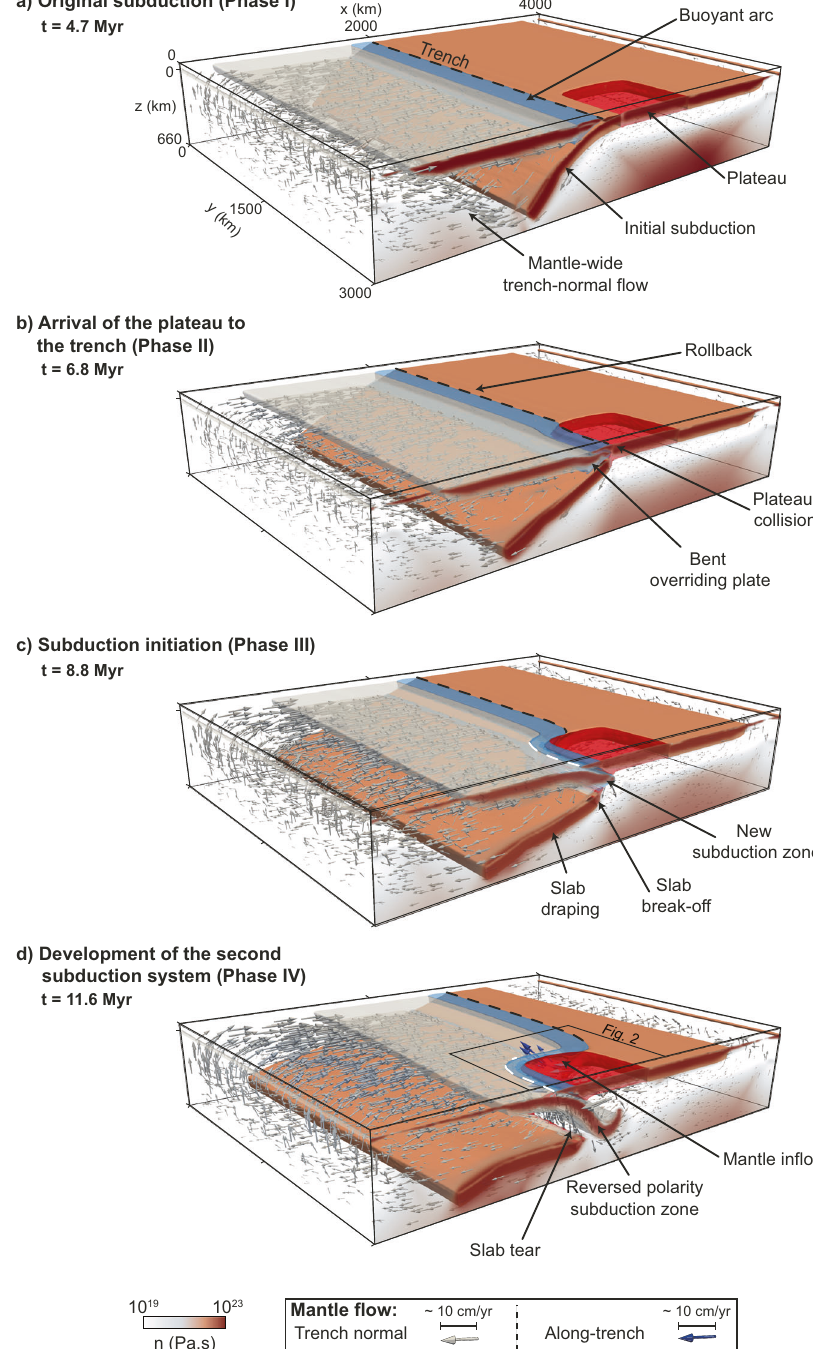
Fig. 1 Reference model evolution of polarity reversal subduction initiation. The mantle fl ow is illustrated with arrows: trench-normal mantle fl ow is shown in white arrows; along-trench fl ow is marked by blue arrows. Subduction trenches are marked by dashed lines: initial subduction in black, newly formed opposite dipping subduction in white. a Phase I — Early evolution of the original subduction. During this stage, the plateau is still moving towards the active subduction trench and a mantle-wide trench-normal fl ow is observed. b Phase II — Initial plateau collision. During this stage, the plateau arrives at the subduction trench and, due to its positive buoyancy, blocks it. Laterally, the initial subduction is still active and continues to steadily rollback. c Phase III — Subduction polarity reversal. Driven by the slab pull exerted by the laterally ongoing original subduction, the plateau is forced onto the overriding plate. Consequently, the overriding plate is underthrusted and, eventually forced to subduct in the opposite direction. The original slab is broken-off below the plateau. d Phase IV — Opposite polarity double subduction system. At this stage, both subduction zones are dynamically maintained by the slab pull of each of their sinking slabs. As the newly formed subduction undergoes trench rollback and migrates laterally, a mantle upwelling forms below the plateau (see Fig.